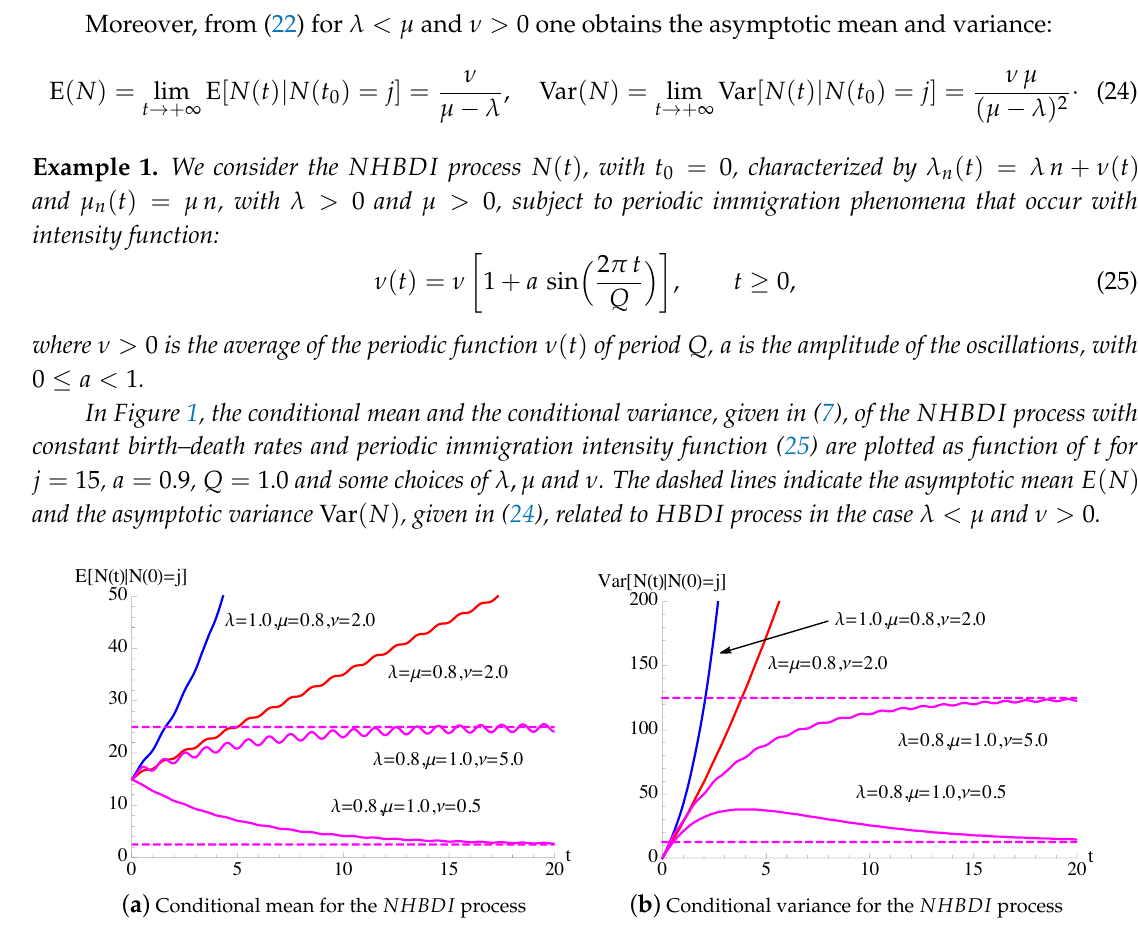
Figure 1. For the time-inhomogeneous linear birth–death process with immigration ( NHBDI ) having λ n ( t ) = λ n + ν ( t ) and µ n ( t ) = µ n , with ν ( t ) given in (25), the conditional mean and the conditional variance (7) are plotted as function of t for j = 15, a = 0.9, Q = 1.0 and for some choices of λ , µ , ν . The dashed lines indicate the asymptotic mean and the asymptotic variance of the HBDI process, given in